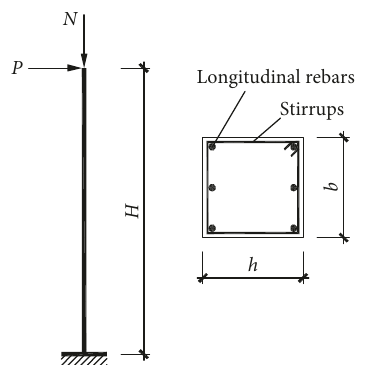
Figure 19: Dimensions and reinforcement details of the RAC columns. Table 4: Key relevant dimensions and material properties of the columns.